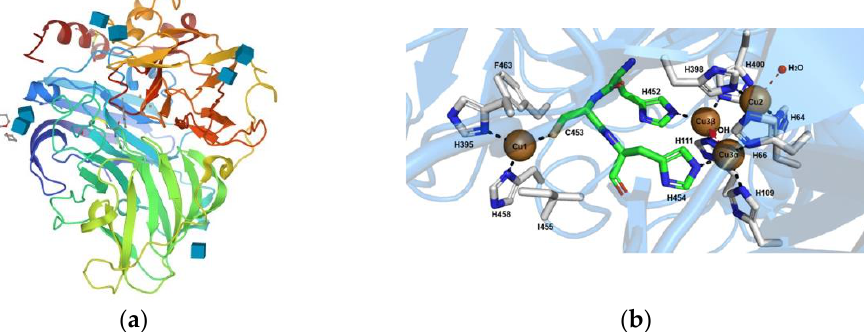
Figure 2. Lac from Trametes versicolor (Protein Data Bank code 1KYA) ( a ). Representation of the different amino acids of the catalytic site that coordinates the T1, T2 and T3 copper sites ( b ), reprinted from Ref. [46].